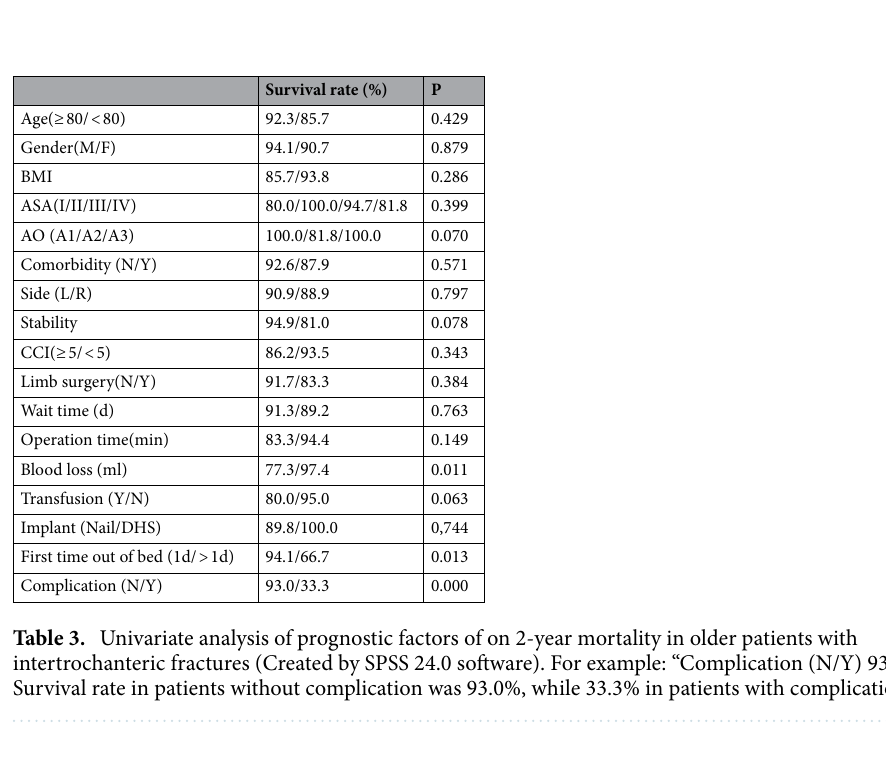
Table 2. The earlier postoperative functional results of the low- and high-CCI groups (Created by SPSS 24.0 software).